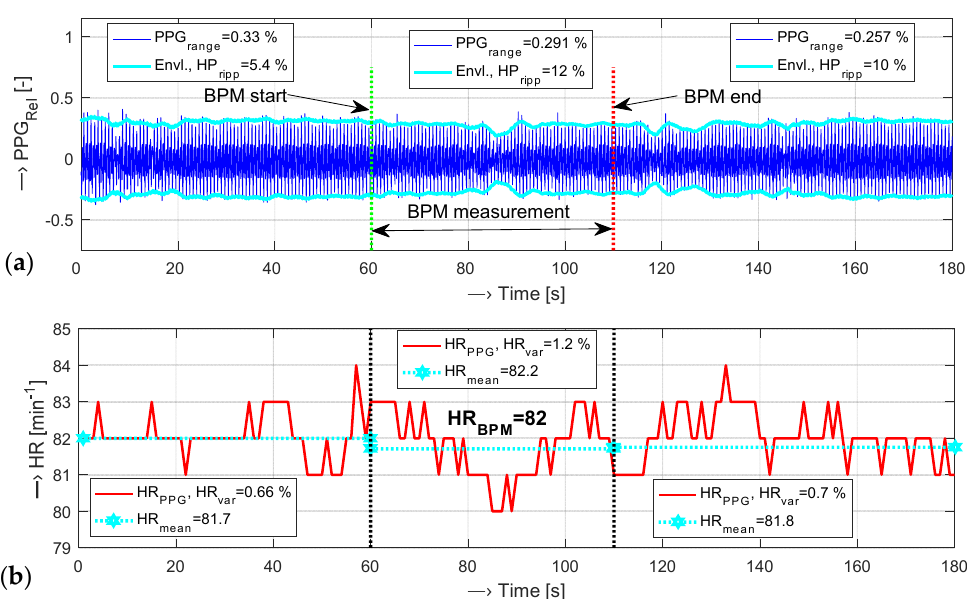
Figure 5. Visualization of a sensed PPG wave with parallel measurement by the BPM device on different arms in three phases (before, during, and after the BPM measurement): ( a ) sensed PPG wave with calculated signal range, envelopes, and ripple, ( b ) HR values from the PPG signal compared with HR BPM together with HR VAR and HR MEAN values; a PPG sensor is worn on a left forefinger, a BPM device on a right arm.